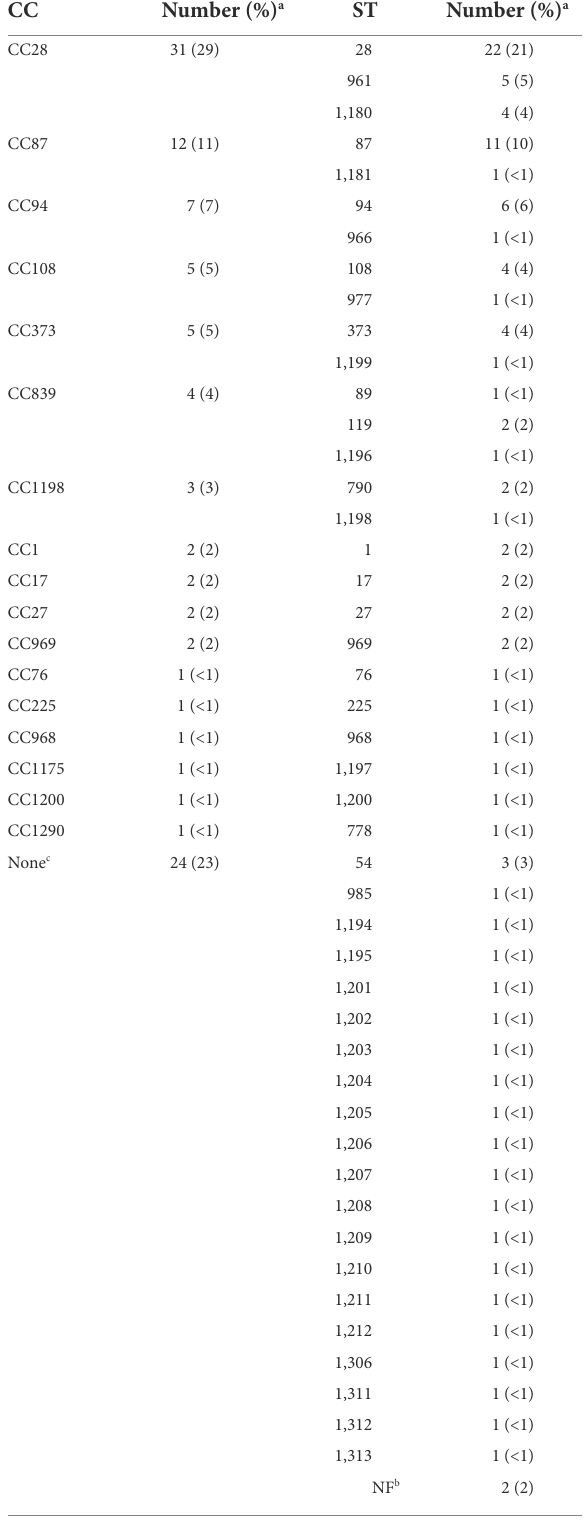
TABLE 1 Prevalence of clonal complexes (CC) and sequence types (ST) among Streptococcus suis